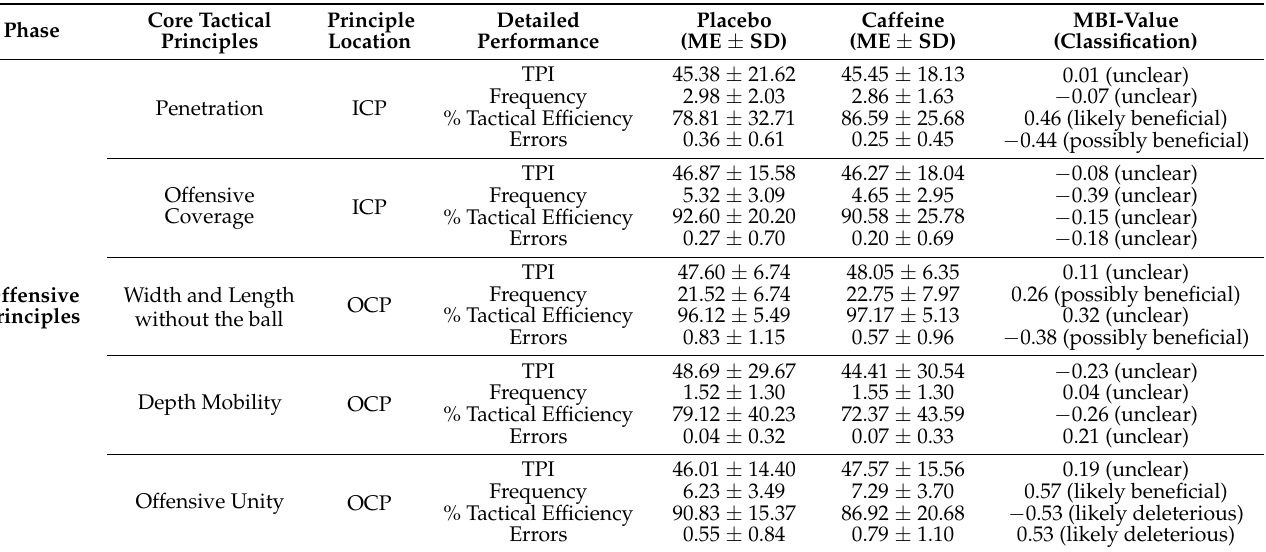
Table 2. Results of the core tactical principles of soccer featuring offensive principles.